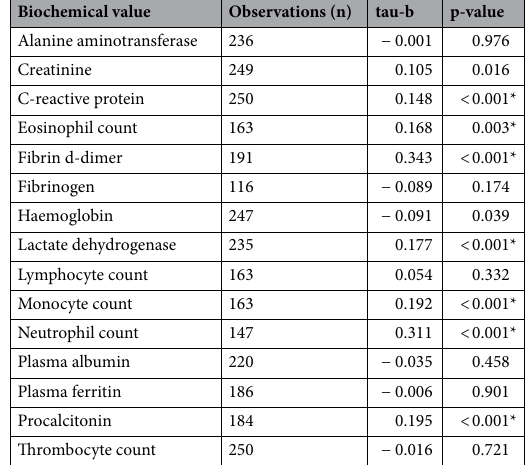
Biochemical value Observations (n)